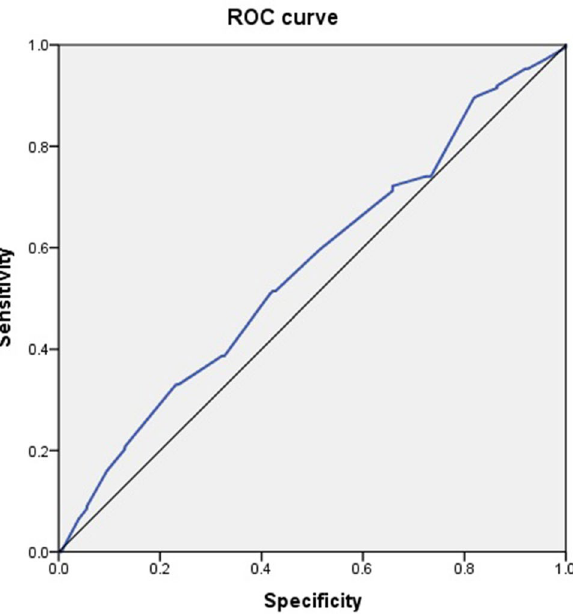
Figure 1. The receiver operation curve of the maximal bladder capacity and global response assessment. With the cut-off value of 760 ml, the area under curve was 0.559, P =